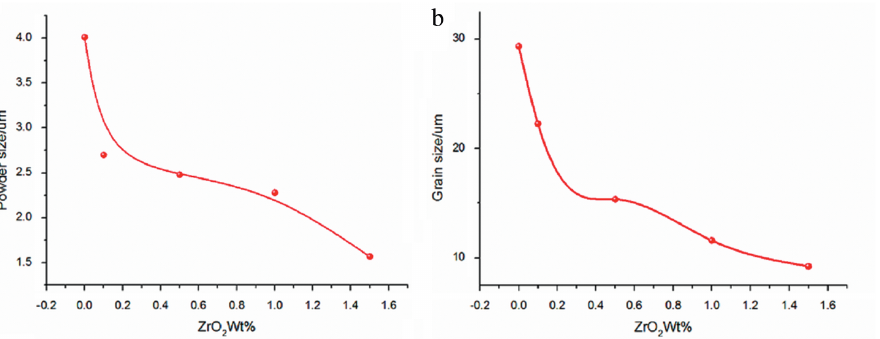
Figure 3: Size of ZrO 2 /Mo: (a) powder size; (b)grain size.